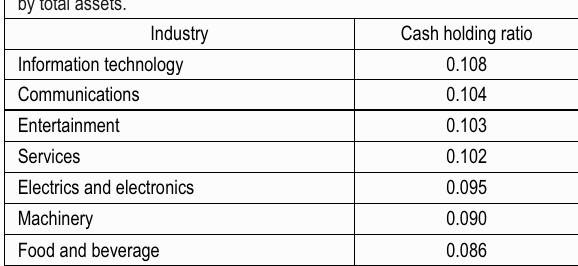
Table 4. Cash holding ratio by industry